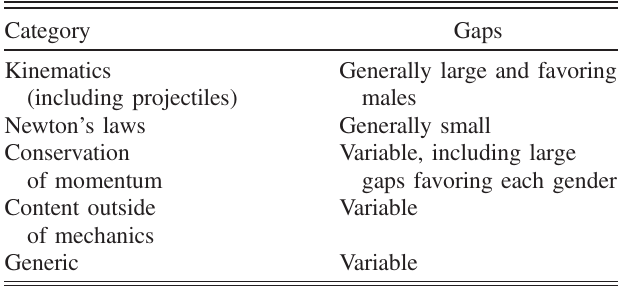
TABLE III. Pattern of gender gaps within the content